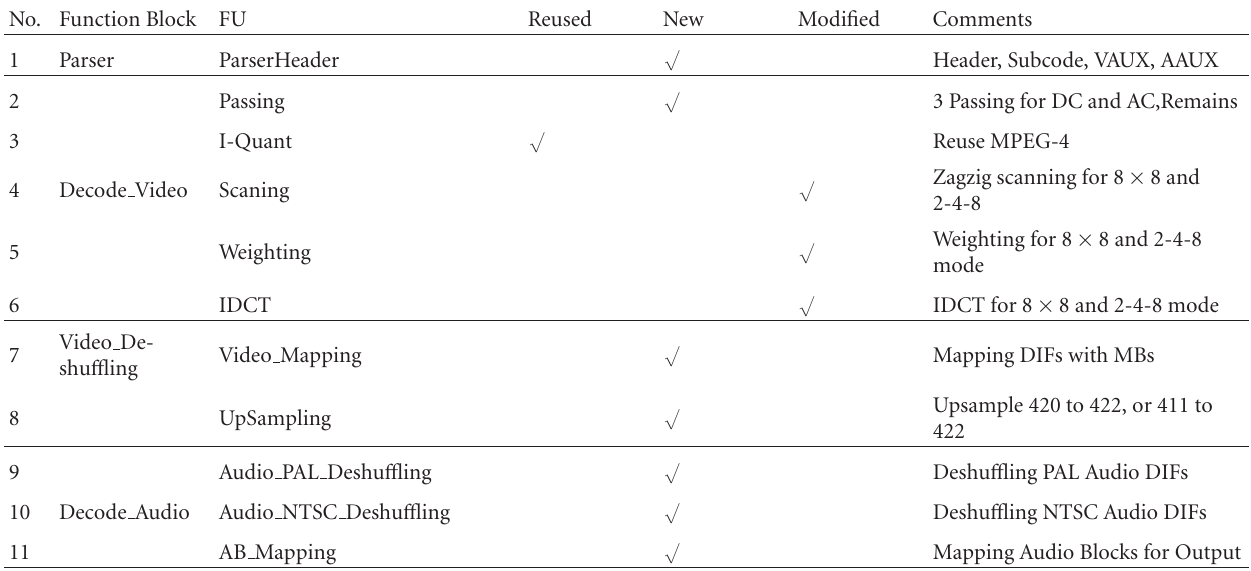
Table 2: FUs reusability of